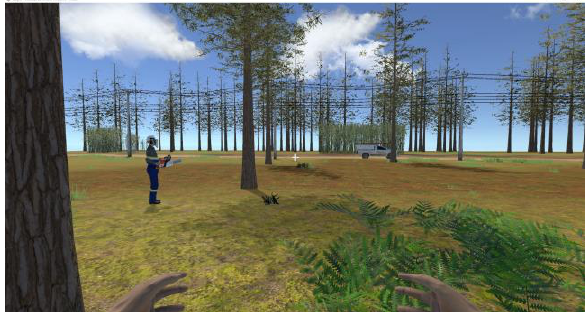
Figure 13. Countryside scenario for the tree cut exercise.